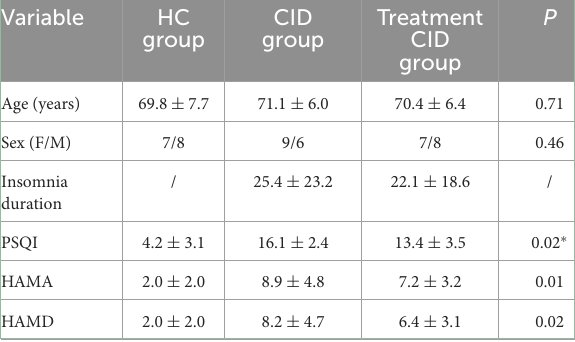
TABLE 1 CID group and treatment CID group demographics. Variable HC CID Treatment group group CID